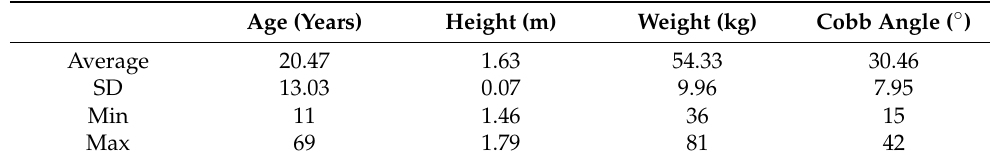
Table 2. Demographic characteristics N = 30